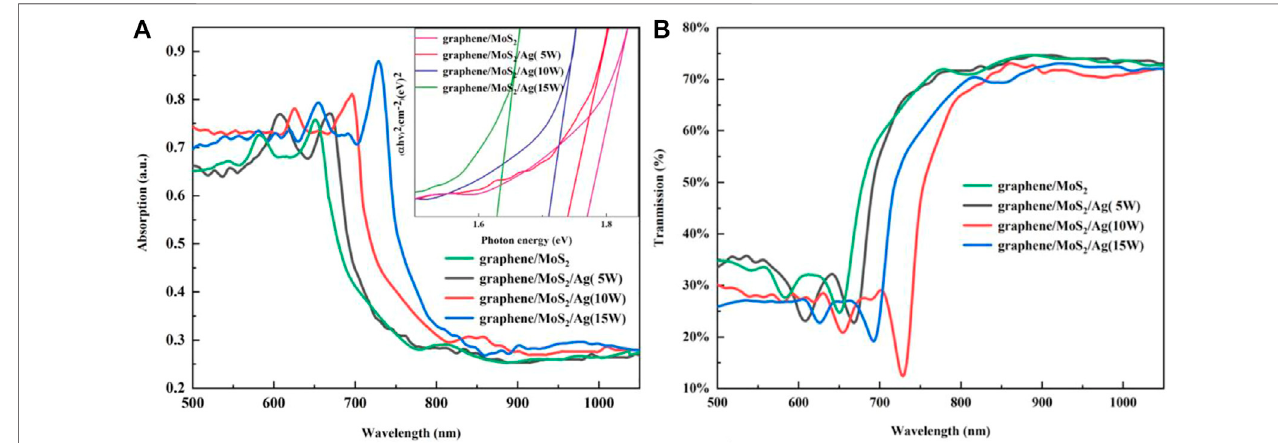
FIGURE 5 | The linear absorption (A) and transmission (B) of the A and B thin fi lms.